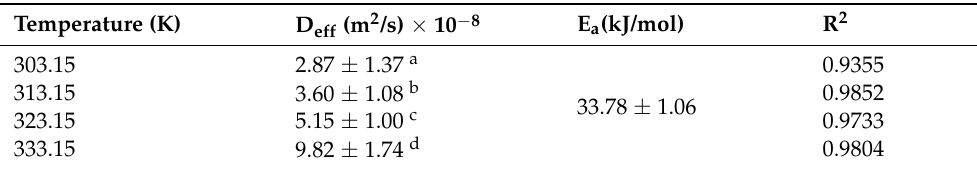
Figure 3. Plot of the ln moisture ratio (ln MR) versus drying time (h) of Kyoho skin. Error bar represents the standard deviation of the mean. Table 4. Effective moisture diffusivity and activation energy for Kyoho skin at different drying temperatures. 1